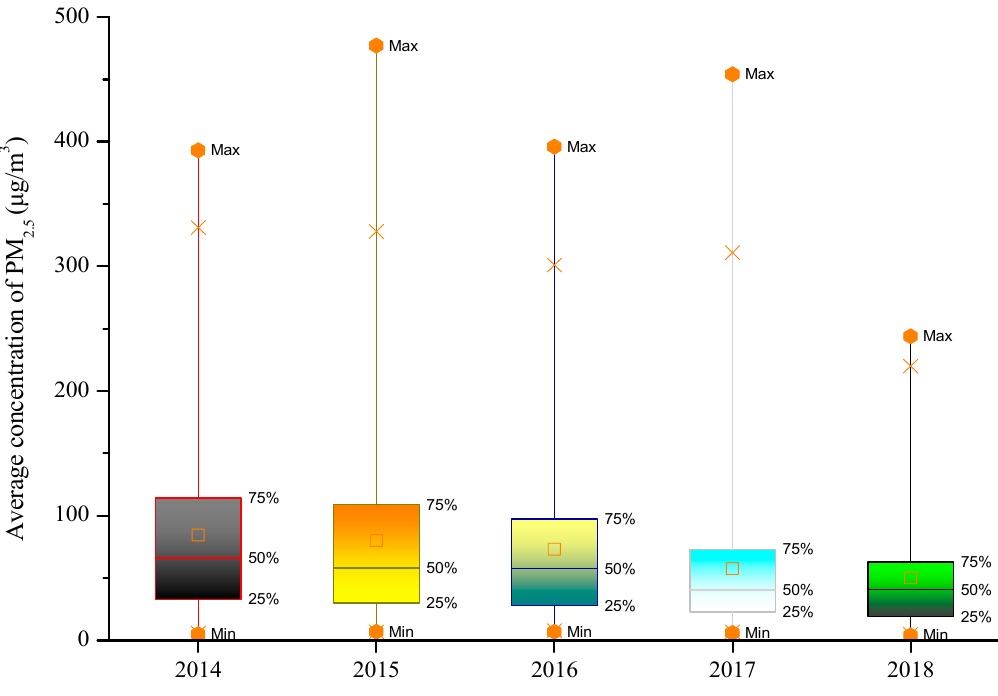
Figure 2. The variation of outdoor PM2.5 average concentration in Beijing, from 2014 to 2018.